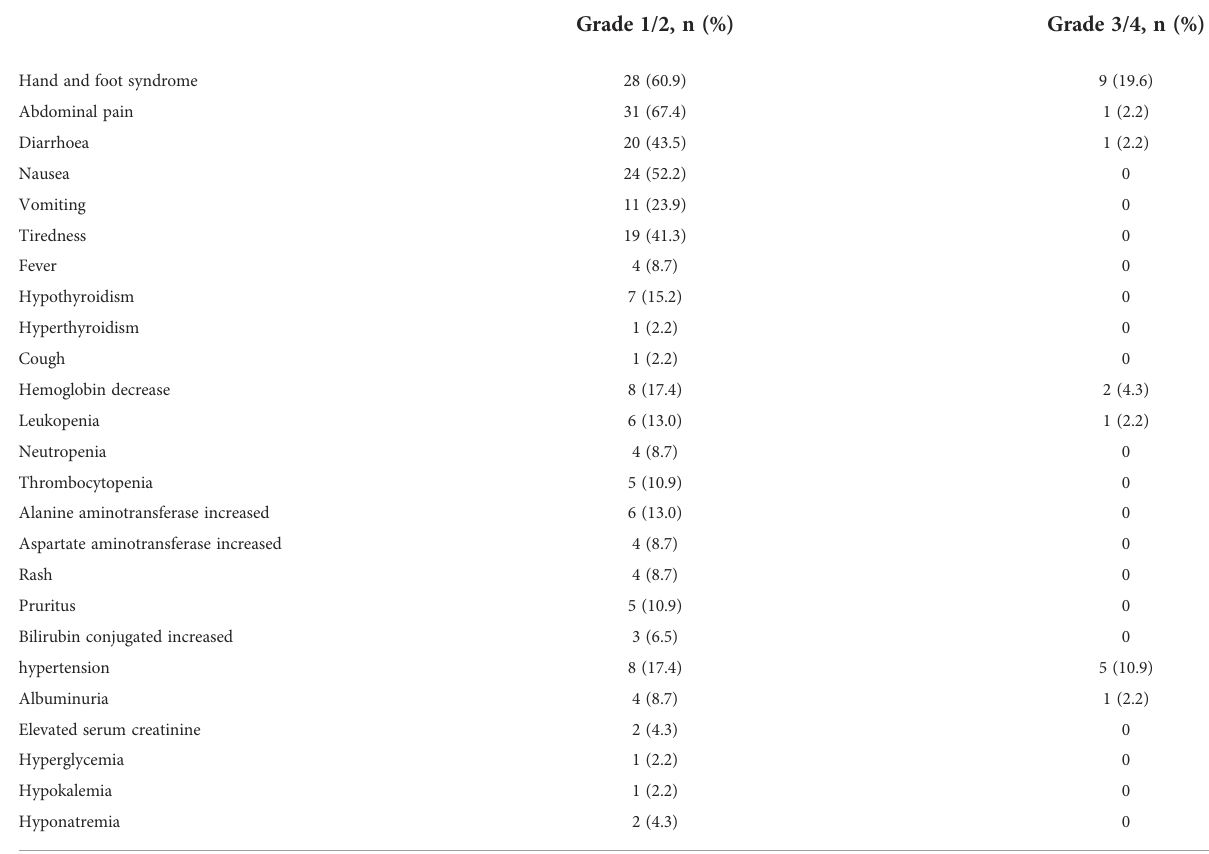
TABLE 3 Treatment-related adverse